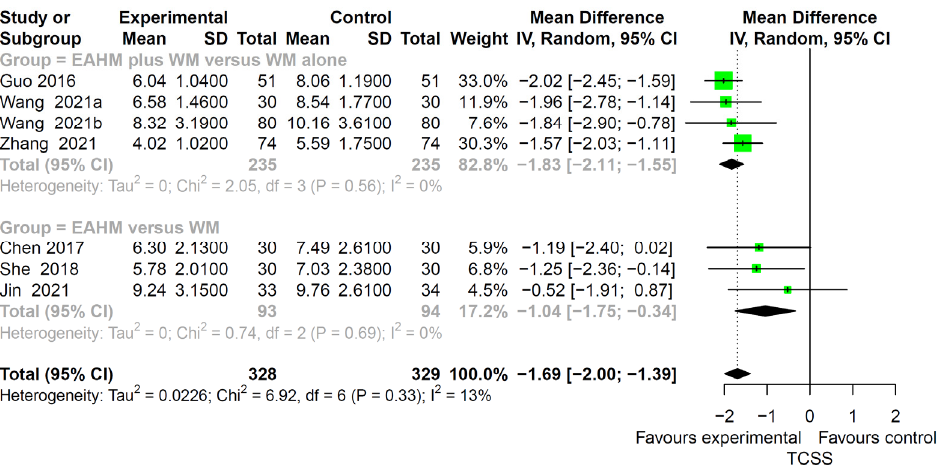
Figure 12. Forest plot of the trials reporting the effect of East Asian herbal medicine monotherapy on the Toronto clinical scoring system (TCSS) for peripheral neuropathy.